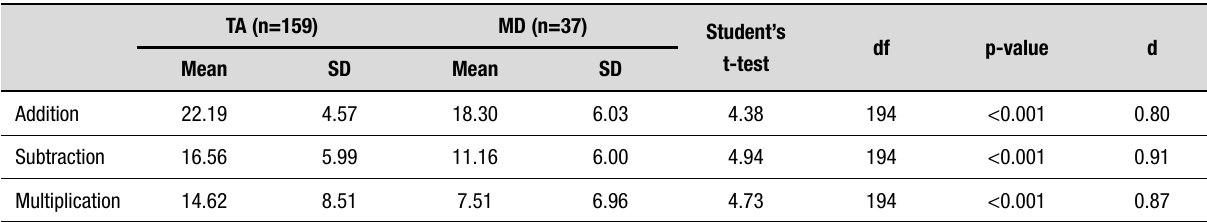
Table 2. Participants’ performance in the Basic Arithmetic Operations